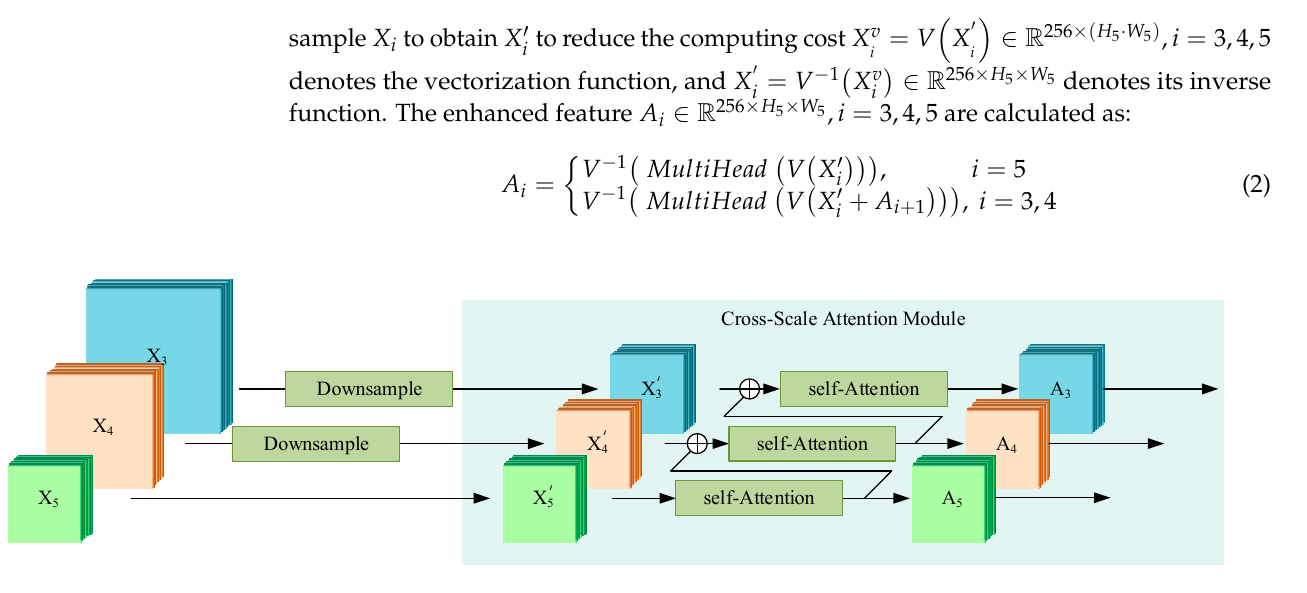
Figure 2. The structure of the cross-scale attention module.